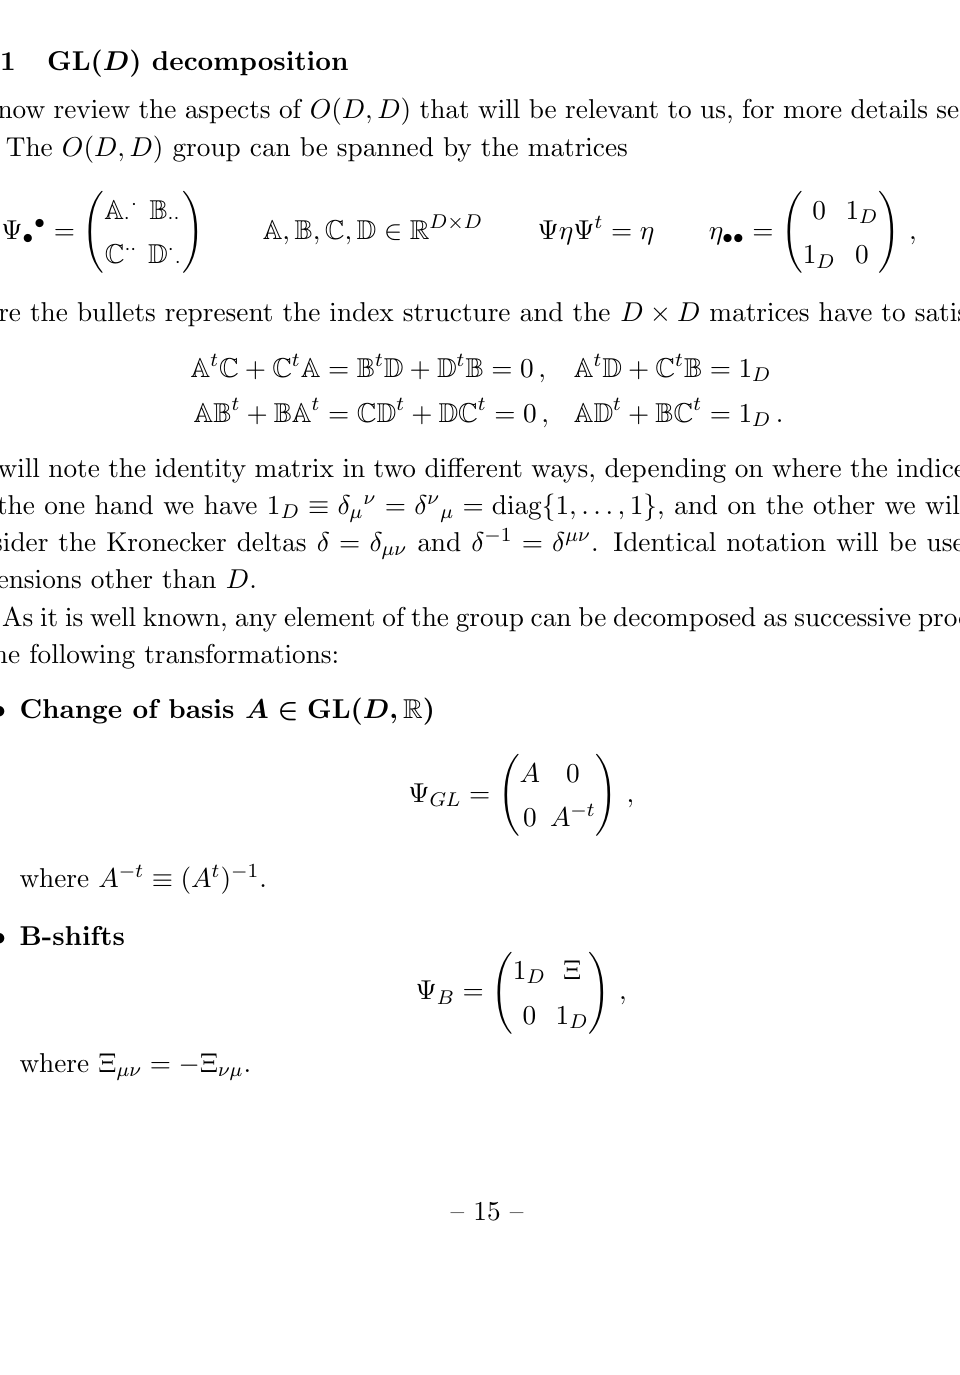
Figure 1 . The inner box represents Gauged DFT where the original and dual backgrounds take the gSS form. There T acts linearly and receives no corrections. The double Lorentz transformations L s and L 0 required to take the generalized frames to a supergravity gauge pull you out of Gauged DFT, s and induce higher order corrections to generalized dualities from the perspective of